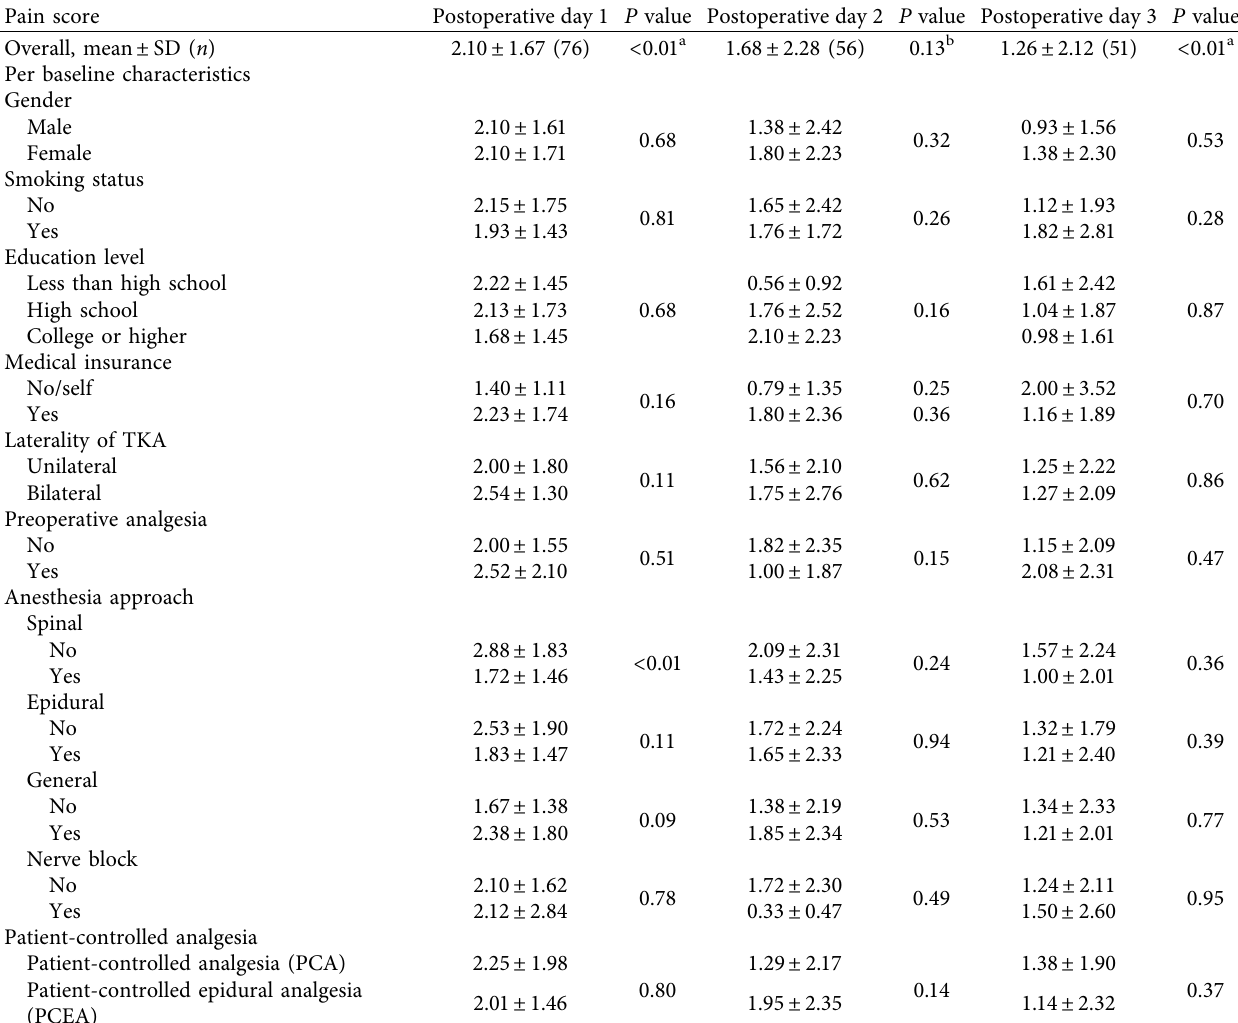
Table 2: The overall and stratified means and standard deviation (SD) of the daily pain scores of the postoperative days one, two, and three. Pain